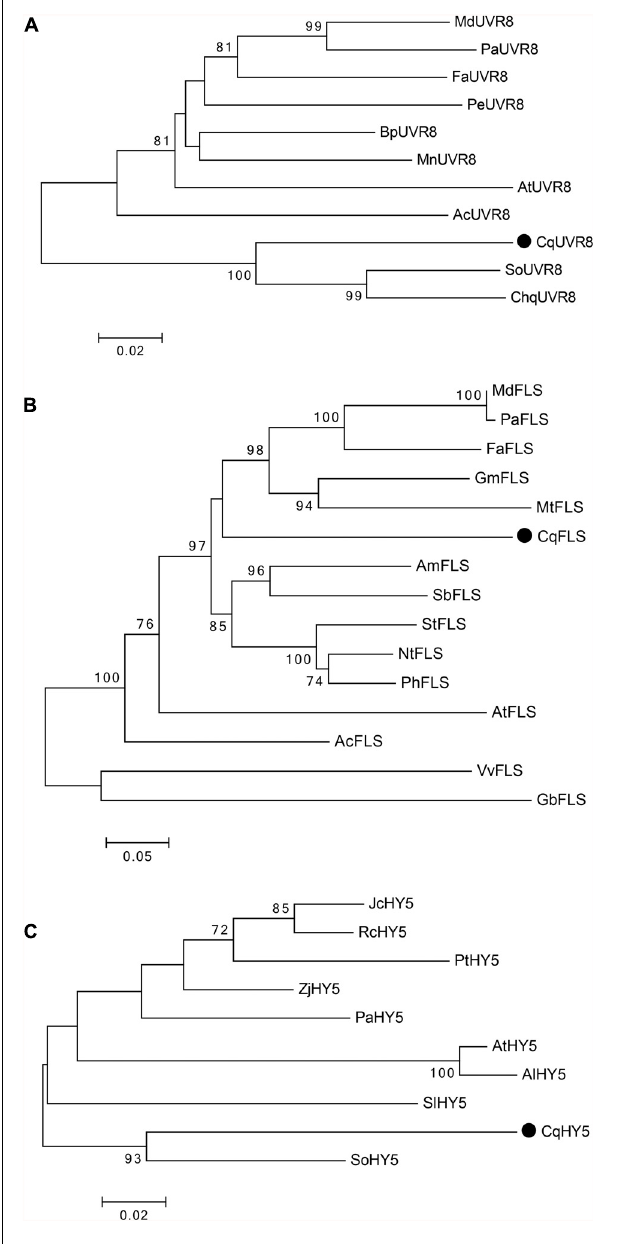
FIGURE 2 | Phylogenetic relationships of the deduced UVR8, FLS, and HY5 proteins from C. quitensis with several plant UVR8, FLS and HY5 proteins. (A) Phylogenetic analysis was performed using the following plant UVR8 proteins: Ananas comosus (XP_020107421), Arabidopsis